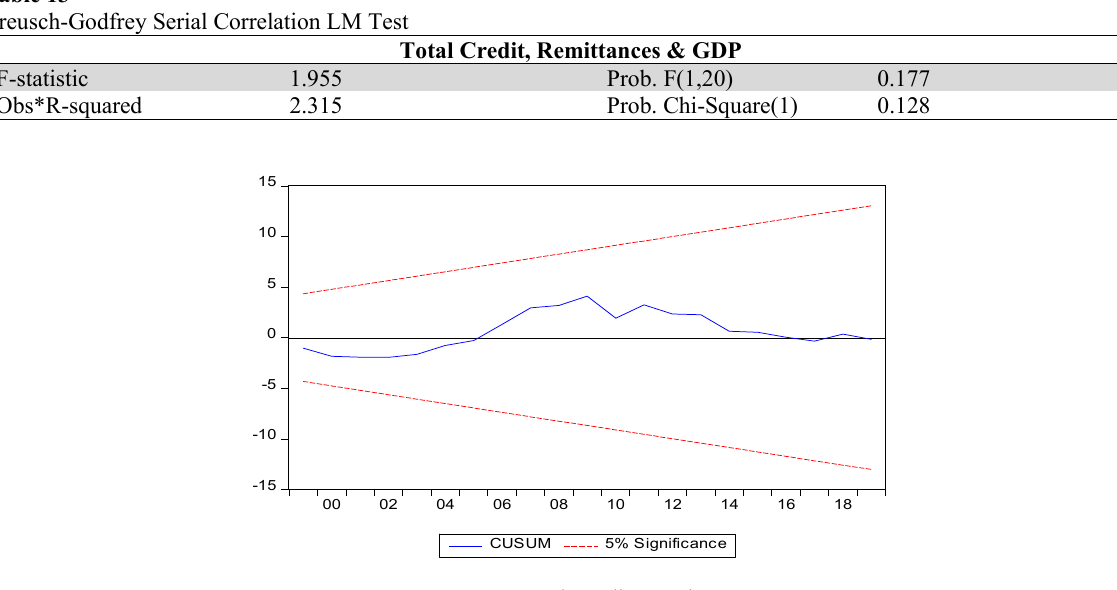
Fig. 4. CUSUM Test: Total Credit, Remittances &